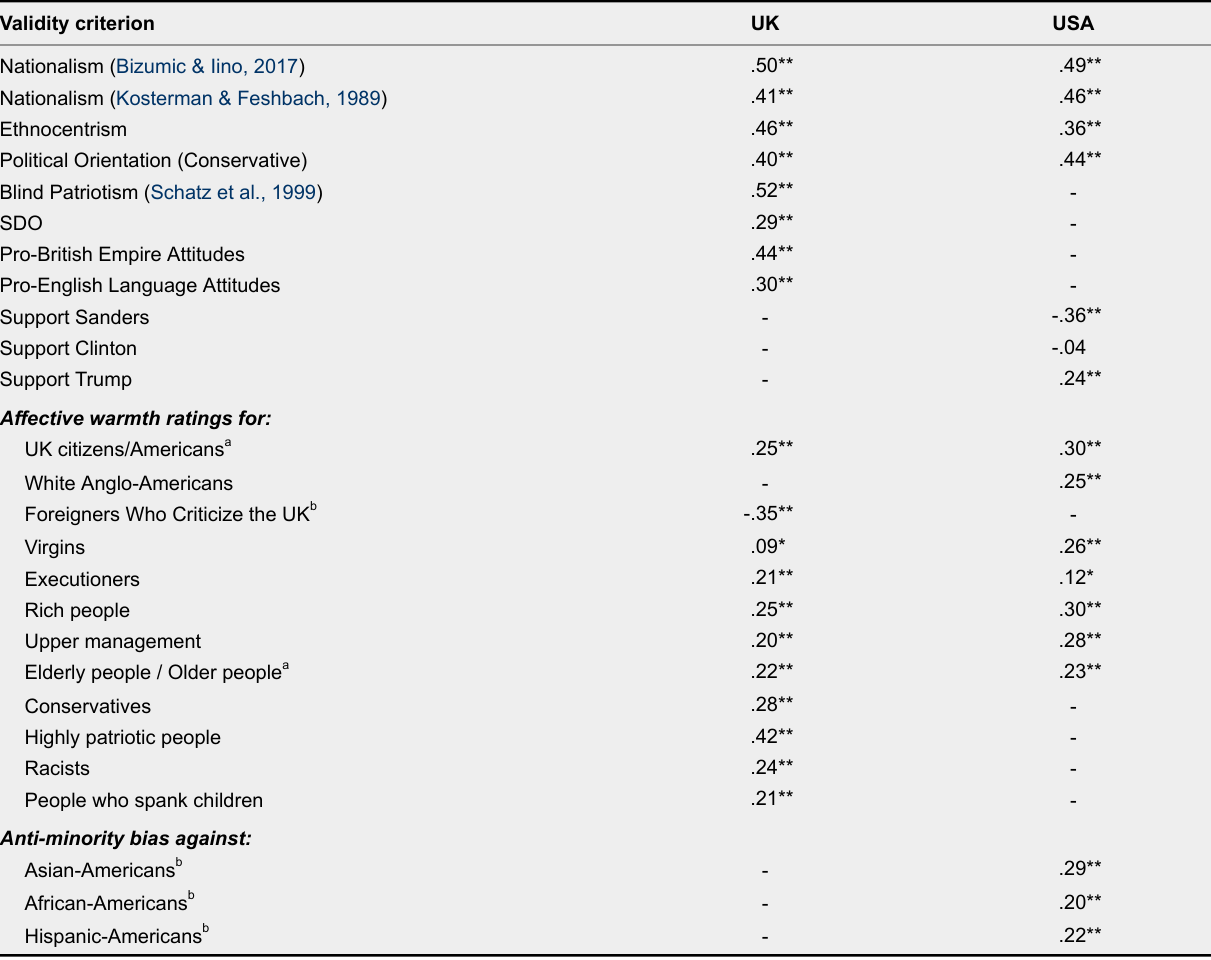
Correlations of the VSA Scale With Validity Indicators of Authoritarianism for the UK (N = 522) and US Samples (N = 375) USAUKValidity